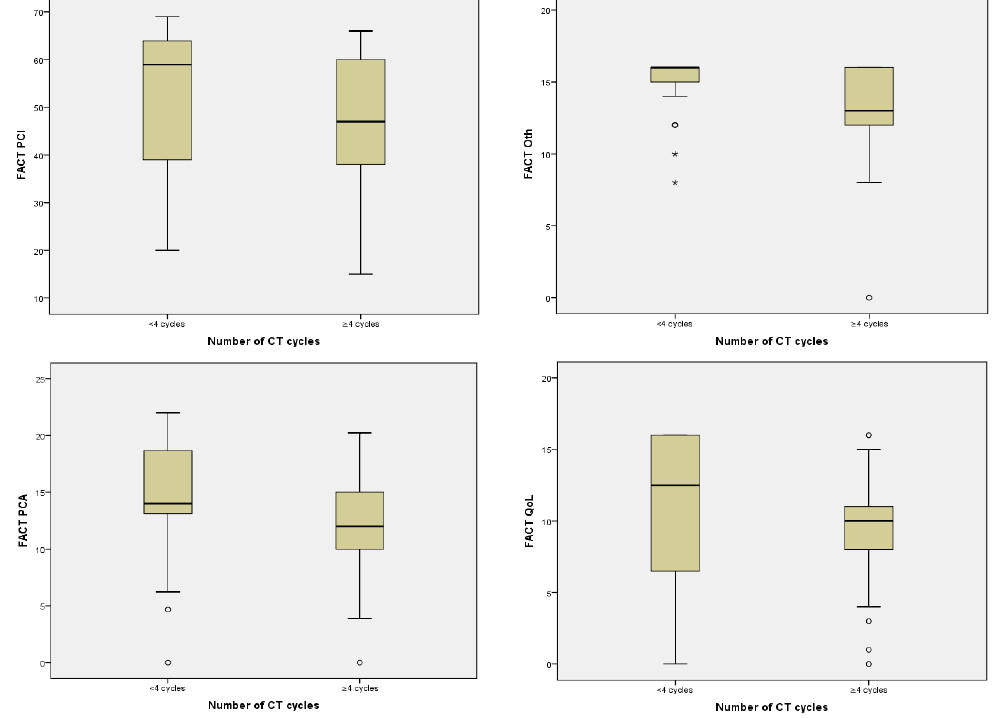
Figure 1. Relationship between number of CT cycles and FACT-Cog scales.